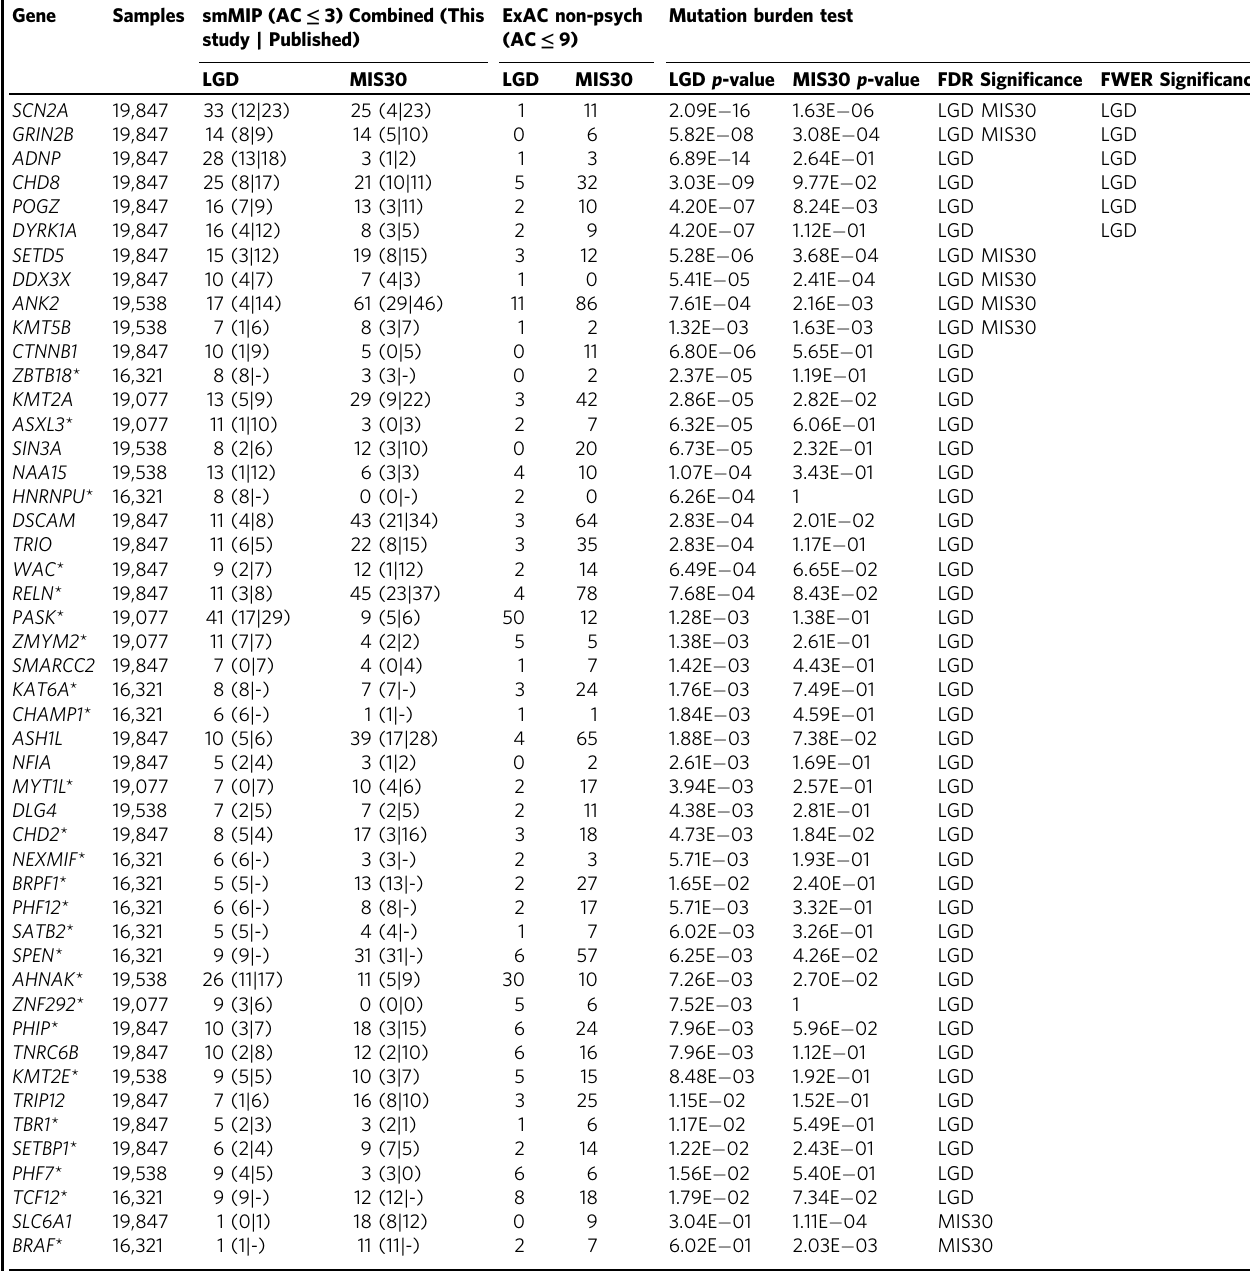
Table 1 Genes with a signi fi cant burden for ultra-rare severe variants. Gene Samples smMIP (AC ≤ 3) Combined (This study |